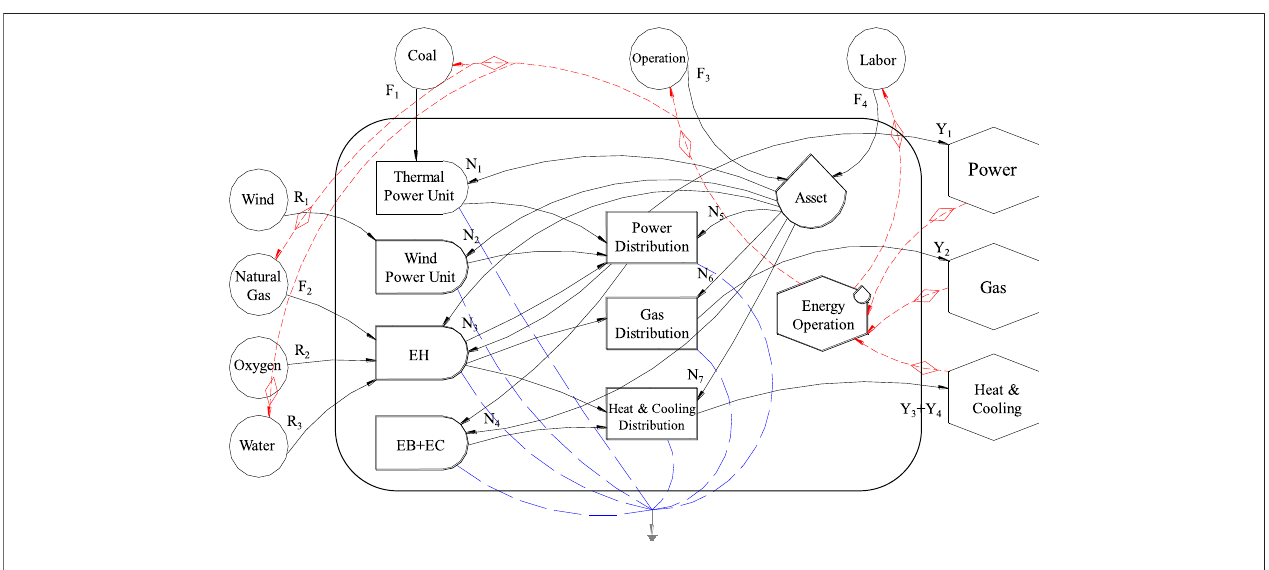
FIGURE 2 | IES emergy analytical